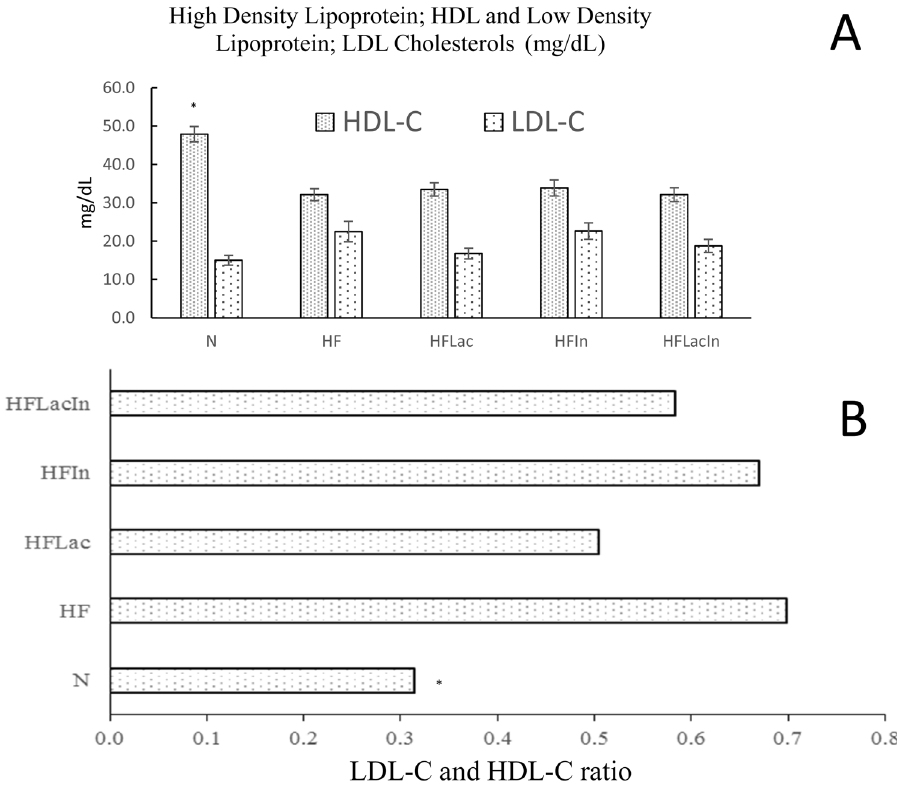
Figure 2. Serum HDL (mg/dL)- and LDL-cholesterol concentrations of the rats in each group (n = 13). (N) Rat fed a normal diet (HF) Rats fed with a high fat diet (HFLac, HFIn, HFLacIn) Rats fed with a high fat diet and L. acidophilus , inulin, and L. acidophilus + inulin, respectively. (A) Serum HDL-C and LDL-C concentrations and (B) the LDL-C/HDL-C ratio.